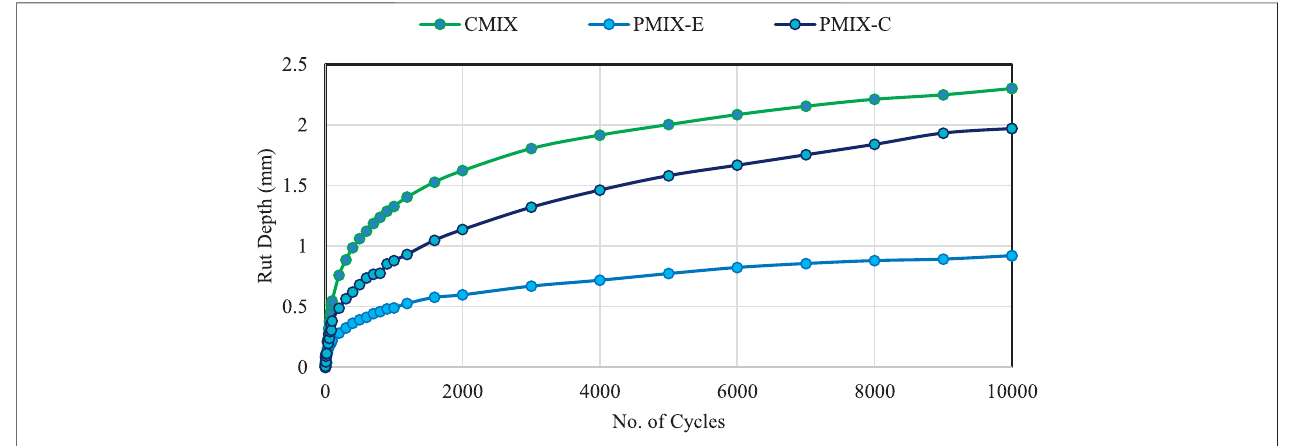
FIGURE 11 | Rut depth vs. the number of